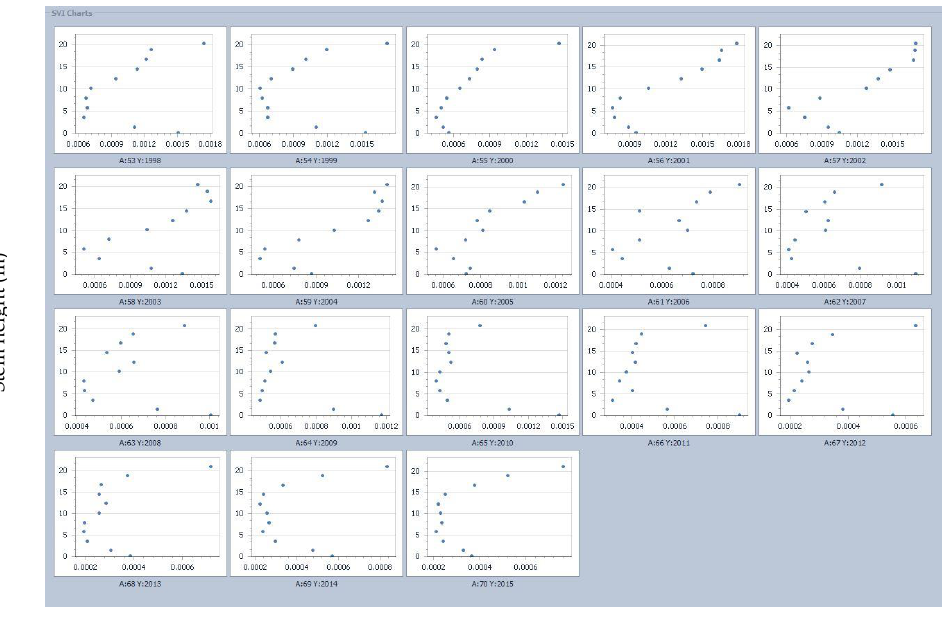
Figure 9. Temporal specific volume increment profiles derived from a 70 year-old jack pine tree illustrating the distribution of relative response throughout the stem for each of the 18 years following the second (last) thinning (1998–2015).